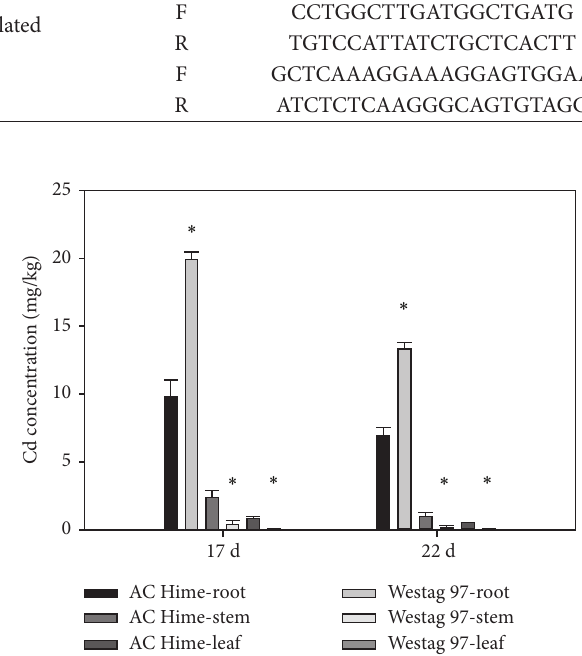
Figure 1: The Cd concentration of three tissues of AC Hime and Westag 97 exposed to 1.6 𝜇 M Cd at different times. The bar represents standard error ( 𝑛 = 3 ). The value that is statistically different at 𝑃 < 0.05 ) is indicated by ∗